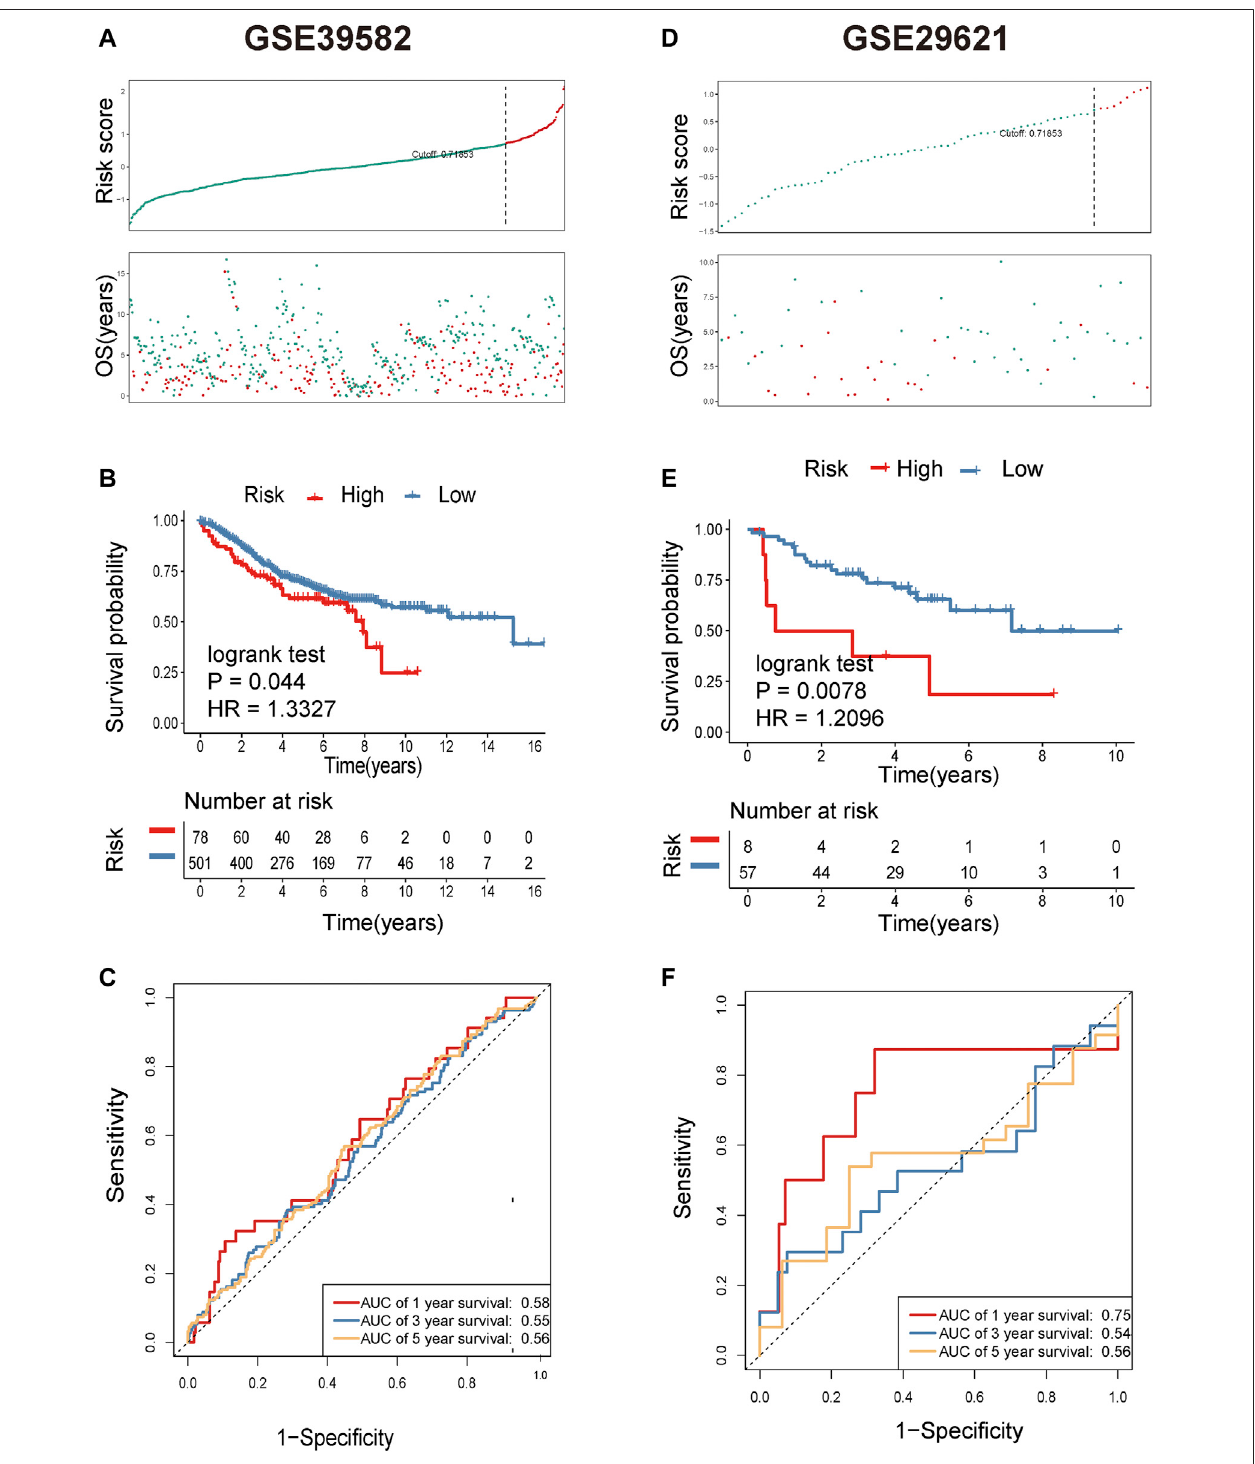
FIGURE 4 | Identi fi cation of metastasis-related lncRNA prognostic signatures for CRC in the GEO cohort. (A) The distribution and value of the risk scores in the GSE39582 cohort. (B) Patients in the high-risk group (red) had worse overall survival (OS) than those in the low-risk group (blue) in the GSE39582 cohort. (C) Receiver operator characteristic (ROC) curves to predict the sensitivity and speci fi city of 1-, 3-, and 5-year survival according to the 8-lncRNA signature-derived risk scores in the GSE39582cohort. (D) Thedistributionand valueoftheriskscoresintheGSE29621cohort. (E) Patients inthehigh-riskgroup(red)exhibitedworseoverallsurvival (OS) than those in the low-risk group (blue) in the GSE29621 cohort. (F) Receiver operator characteristic (ROC) curves to predict the sensitivity and speci fi city of 1-, 3-, and 5-year survival according to the 8-lncRNA signature-derived risk scores in the GSE29621 cohort.